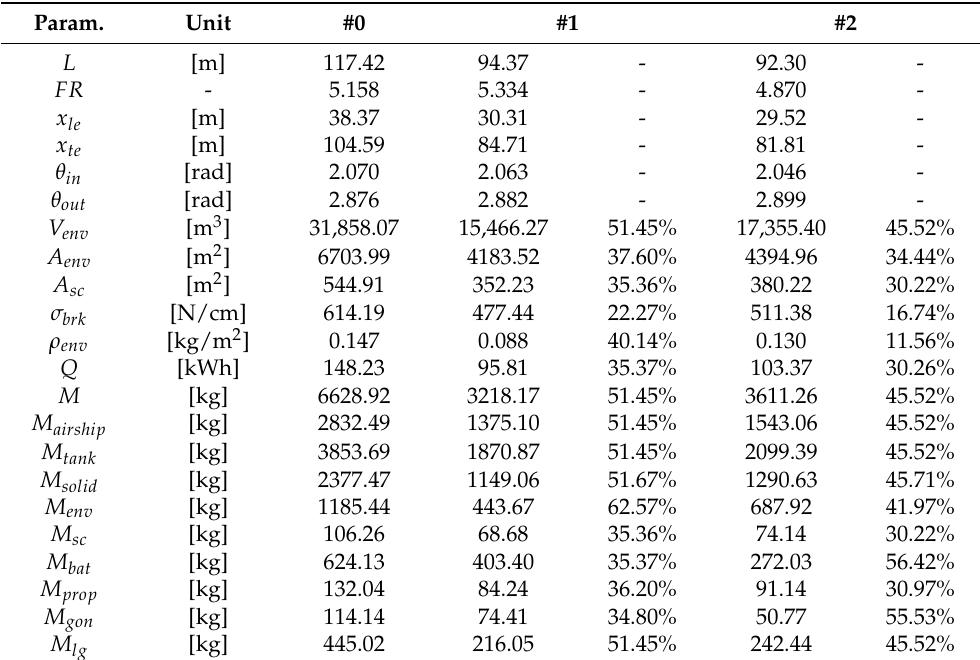
Table 12. Effect of technological advancements and design improvements on optimal design for operation at 20 km altitude above L’Aquila, Italy (Part 1). For each case, the first column gives the absolute value of the parameter, while the second column gives the percent reduction compared to the baseline #0. Param.